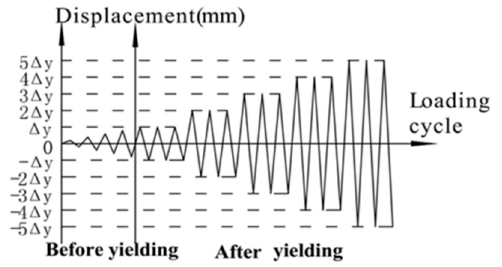
Figure 3. The diagram of loading